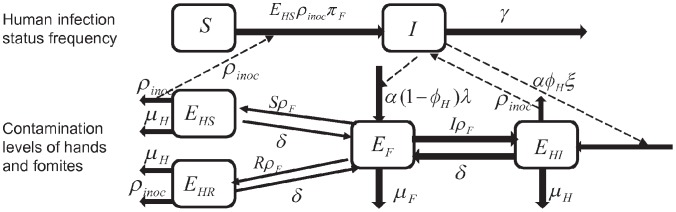
Compartments and transmission routes.The upper part of the figure models the flow of individual compartments. The transfer rate from susceptible (S) to infected (I) is the product of the pathogen amount on hands of susceptible (EHS), the fraction of pathogens EHS transferred to mucus of susceptible via inoculation (ρinoc) and the probability that a susceptible individual becomes infectious per pathogen. The recover rate of infected is γ per unit time. The lower part of the figure models the flow of pathogens. α is the shedding rate per unit time per individual. φH proportion of virus goes directly to the hands of an infected individual. The proportion of virus that is excreted to hands and then is associated with a type of fomite is ξ. λ is the fraction of pathogens going to surfaces reach one type of fomite. ρF is the individual pick up rate of pathogens on a fomite per unit time and δ is the deposit rate of pathogens from hands to fomites per unit time. µ
H and µ
F are virus inactivation rate on hands and fomites respectively.